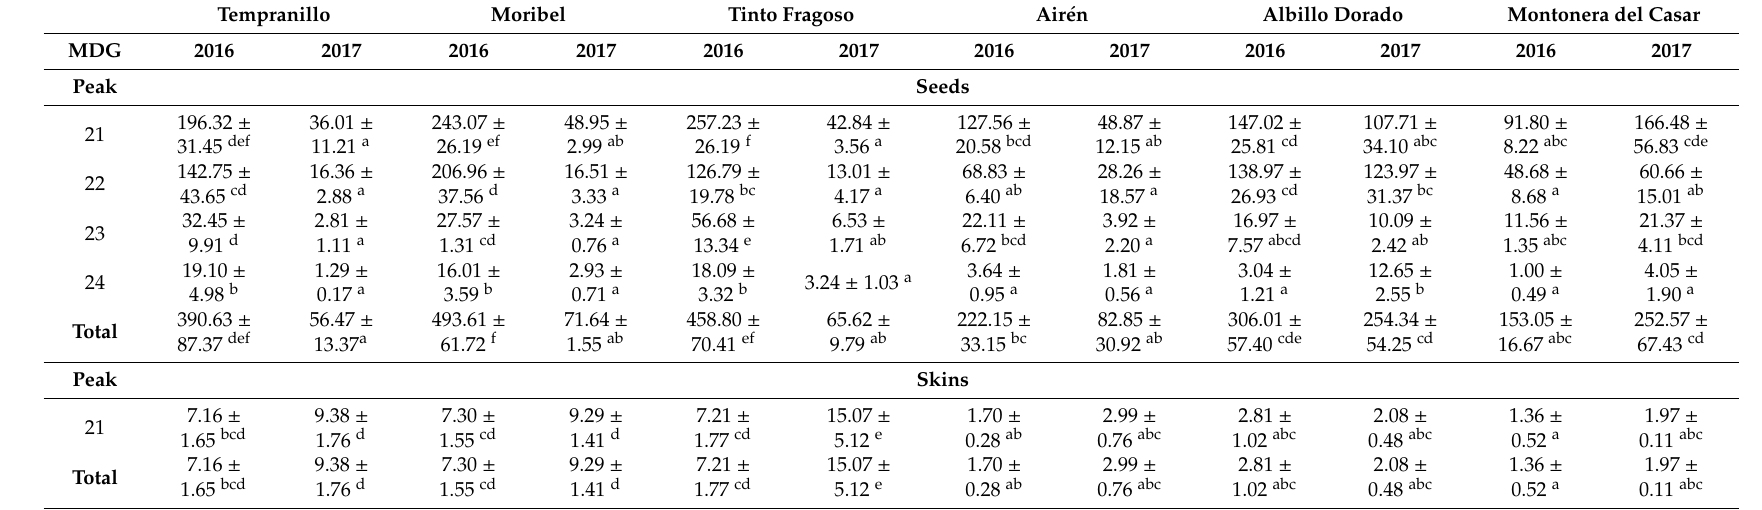
Table 2. Individual and total monomeric flavanol diglycosides (MDG) of skin and seed extracts from Vitis vinifera grape varieties, expressed as µ g / kg grape FW (mean value ± standard deviation, n =